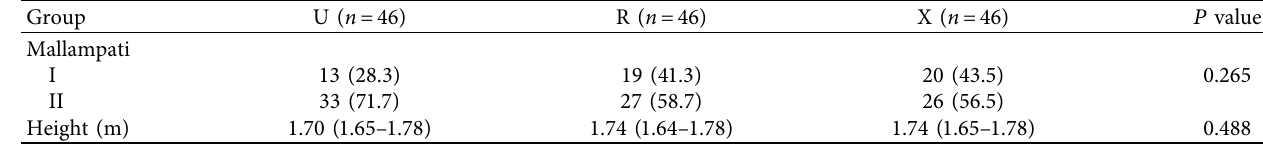
Table 2: Preanaesthetic airway evaluation and anaesthesia trainees’ height.